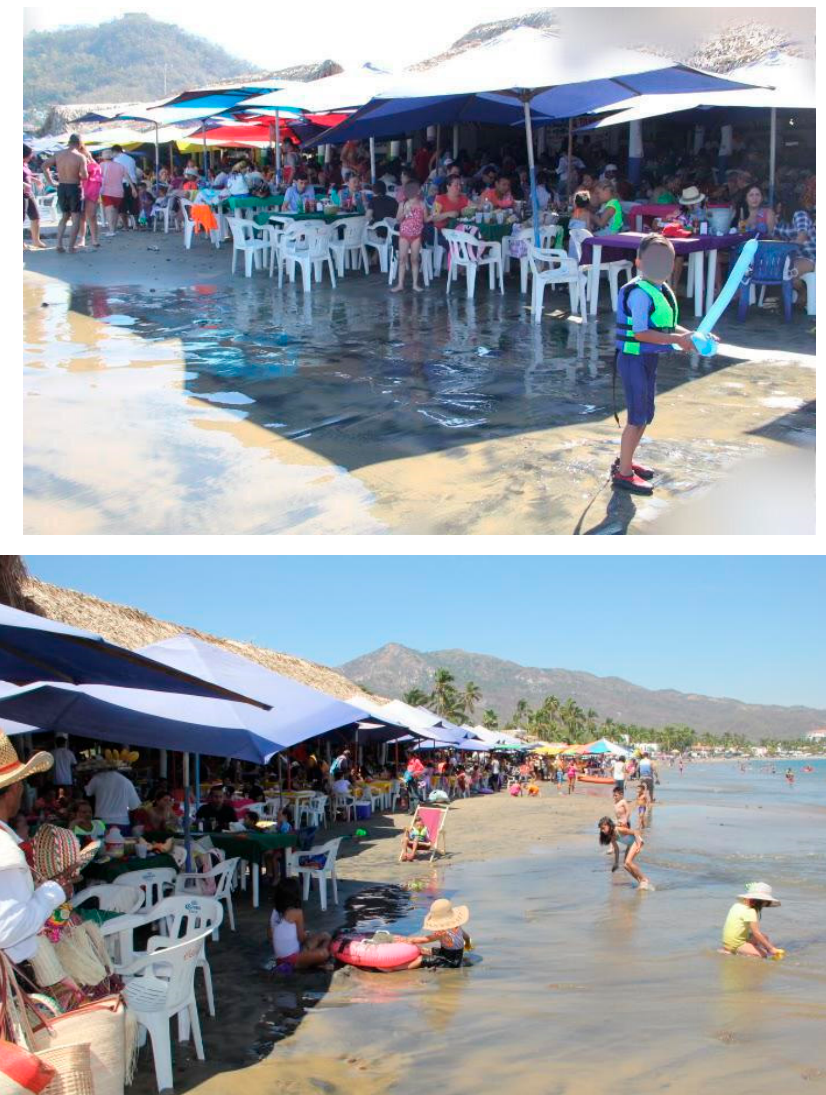
Figure A1. La Boquita Beach in holiday season (above and below). (Photos Omar Cervantes, Ricardo Guzman).